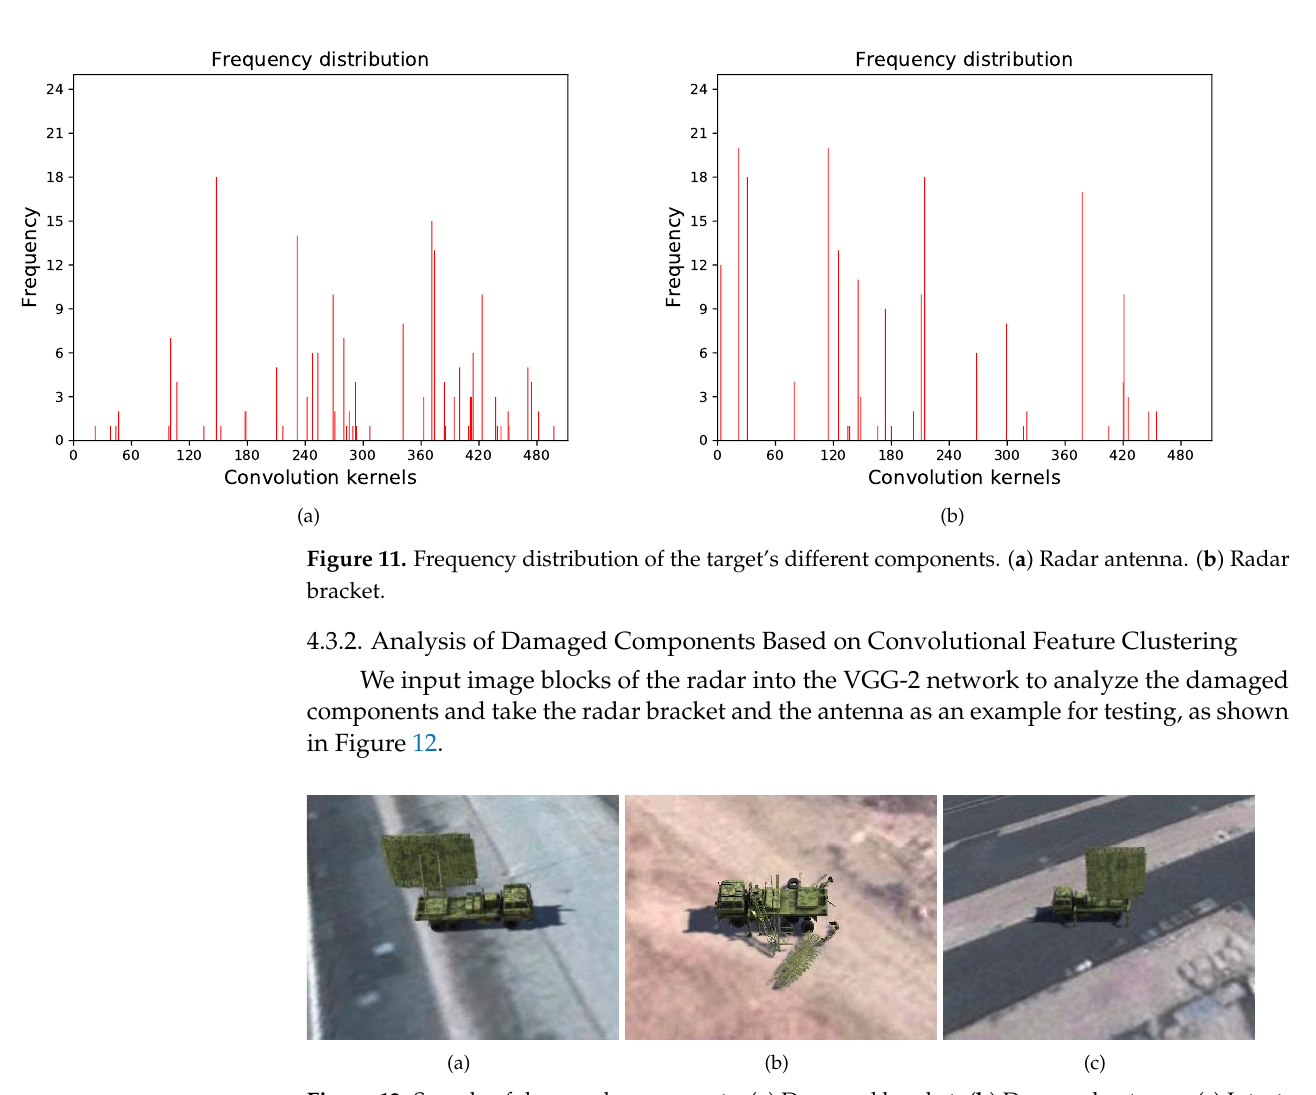
Figure 12. Sample of damaged components. ( a ) Damaged bracket. ( b ) Damaged antenna. ( c )